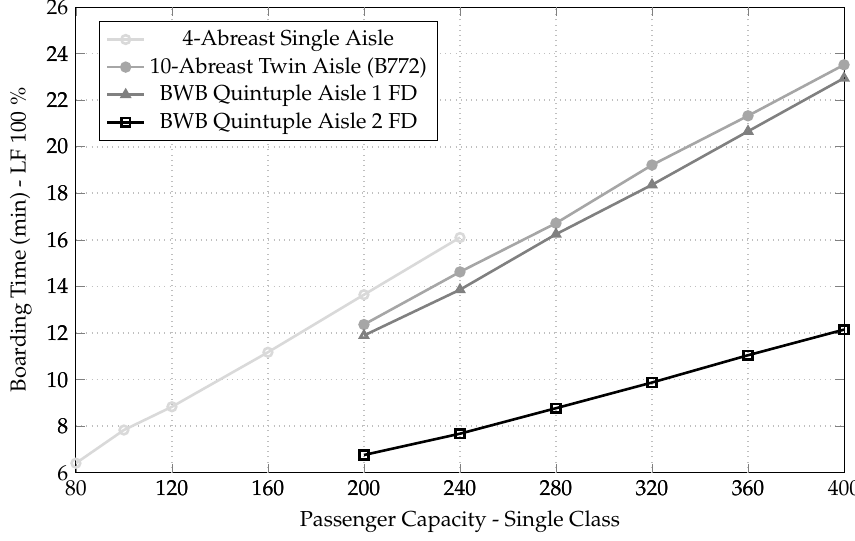
Figure 5. Boarding time (LF: load